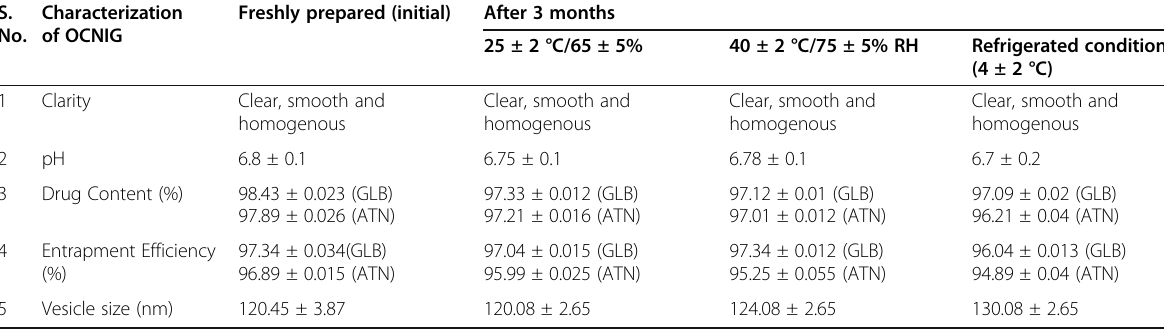
Table 5 Evaluation of stability of